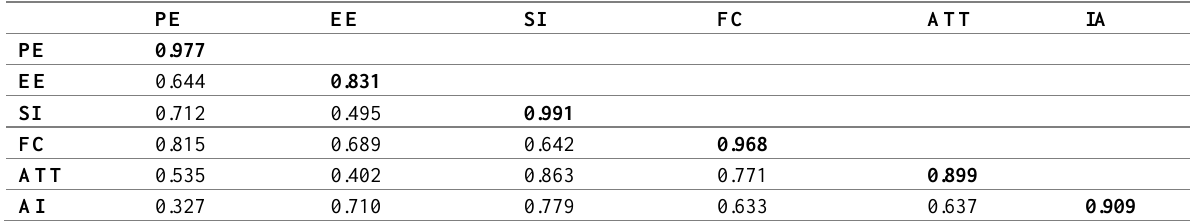
Table 4: Discriminant Validity (Fornell-Larcker